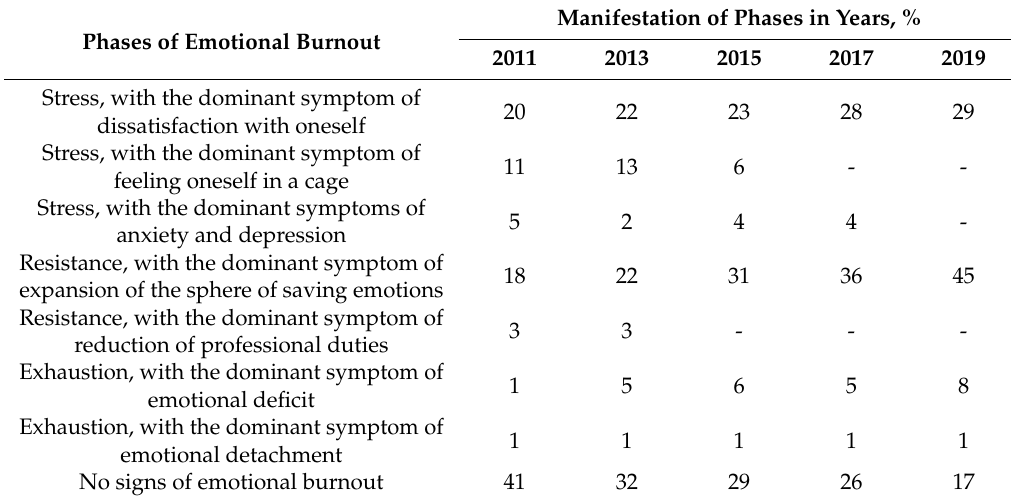
Table 7. Phases of emotional burnout among the senior lecturers in Russian universities.